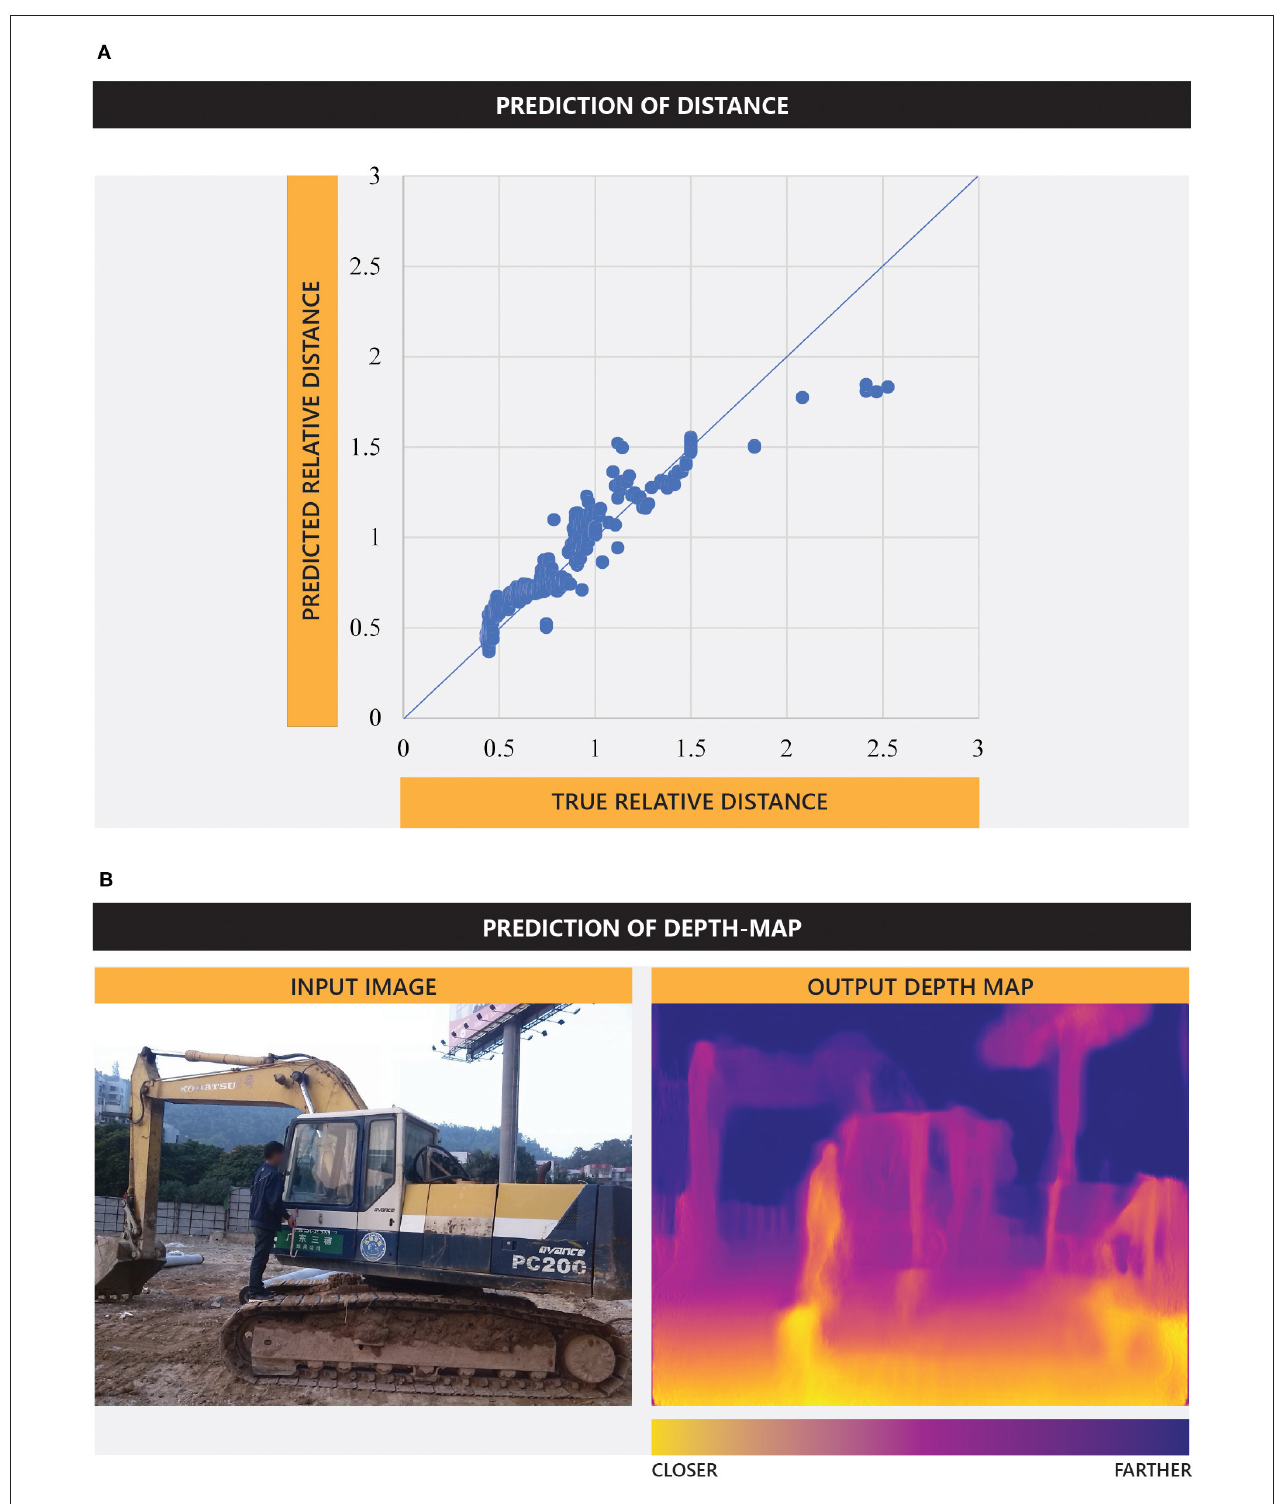
FIGURE 12 | Prediction of (A) distance—true relative distance vs. predicted relative distance, and (B) depth map.